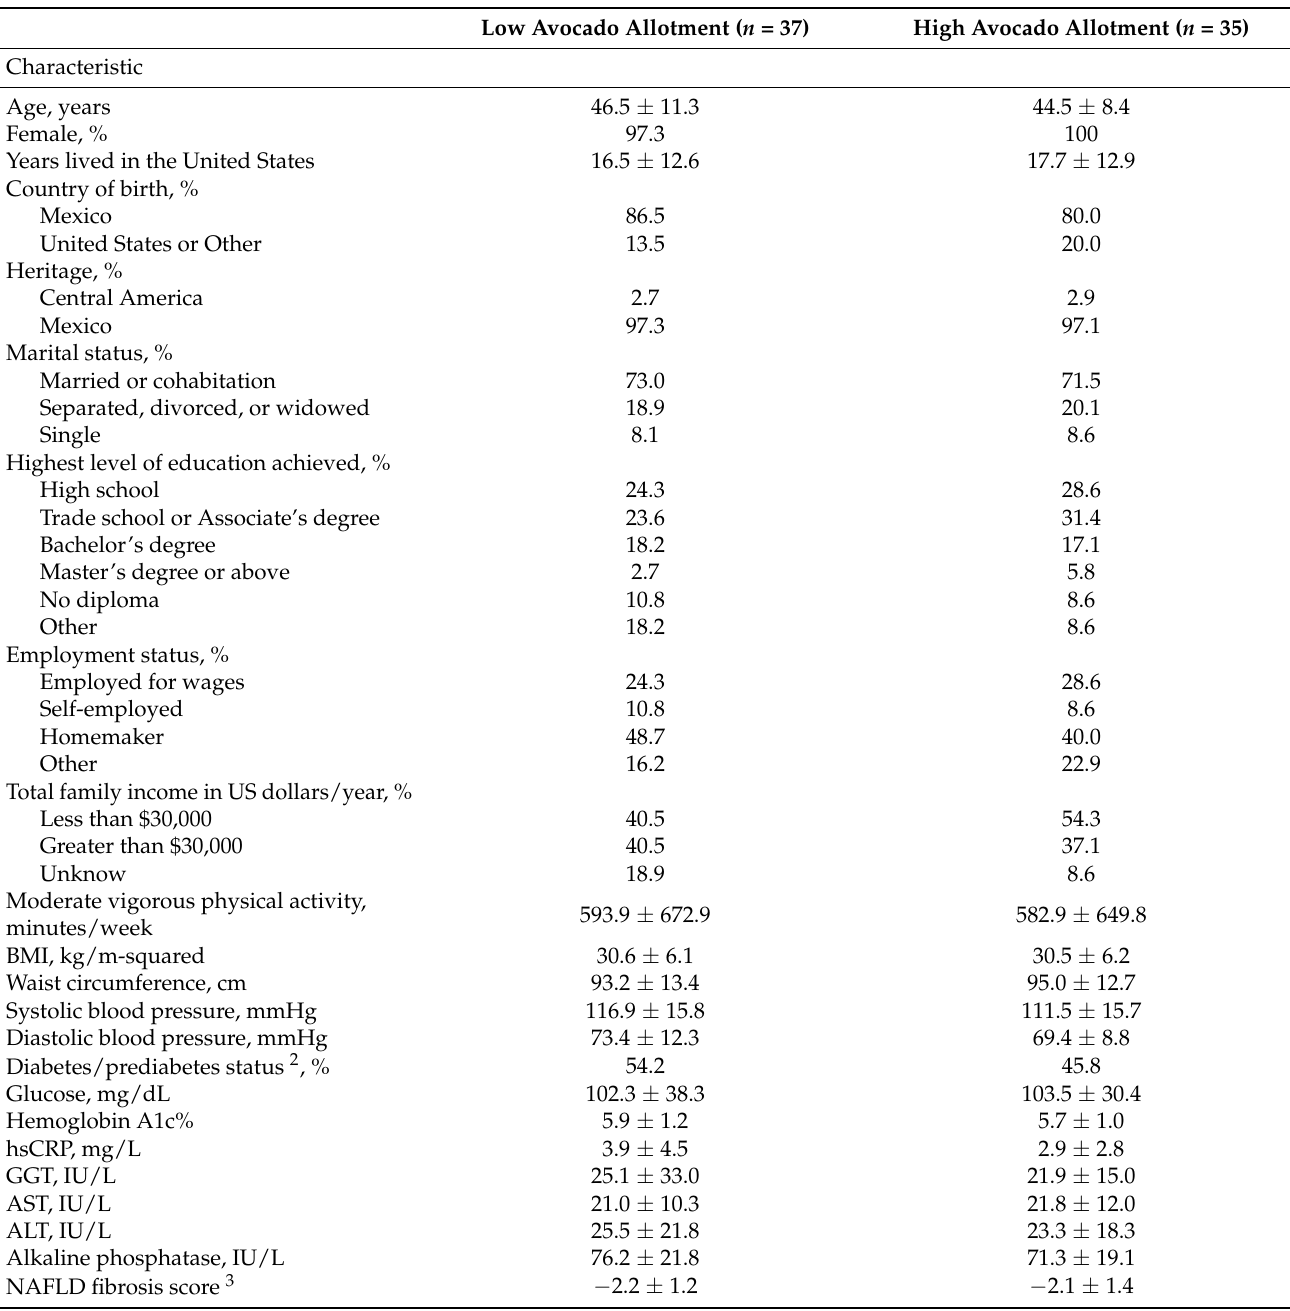
Table 1. Baseline characteristics of randomized participants 1